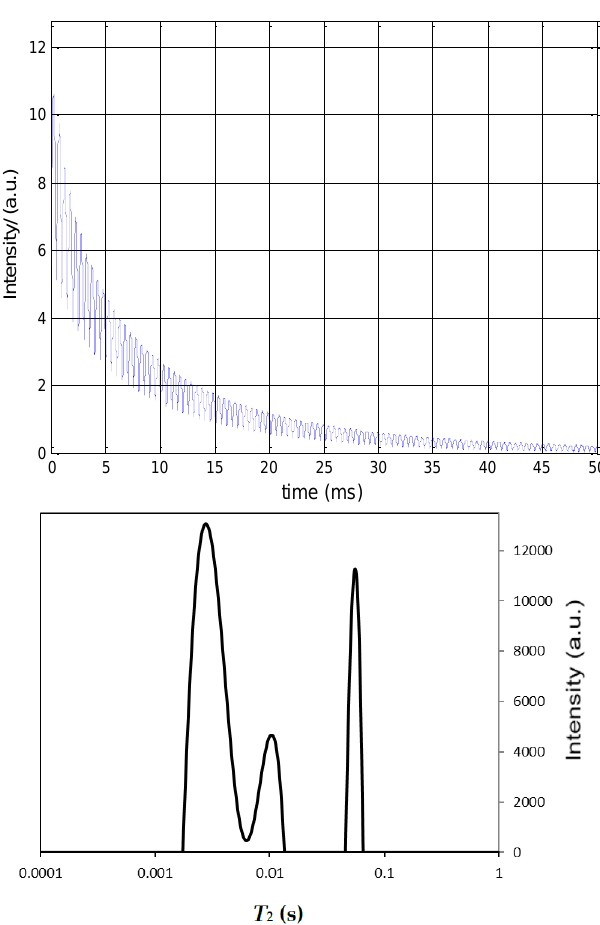
Figure 2. The plots presenting the data from CPMG ( T 2 ) experiment on wood sample with moisture higher than FSP ( T =298K, proton resonance frequency is 400 MHz). Top : the experimental CPMG decay measured after moisturizing the piece of wood. The intensities in the top plot were normalized per 10 3 . Bottom : T 2 distribution obtained from CPMG echo train with the aid of inverse Laplace transformation.